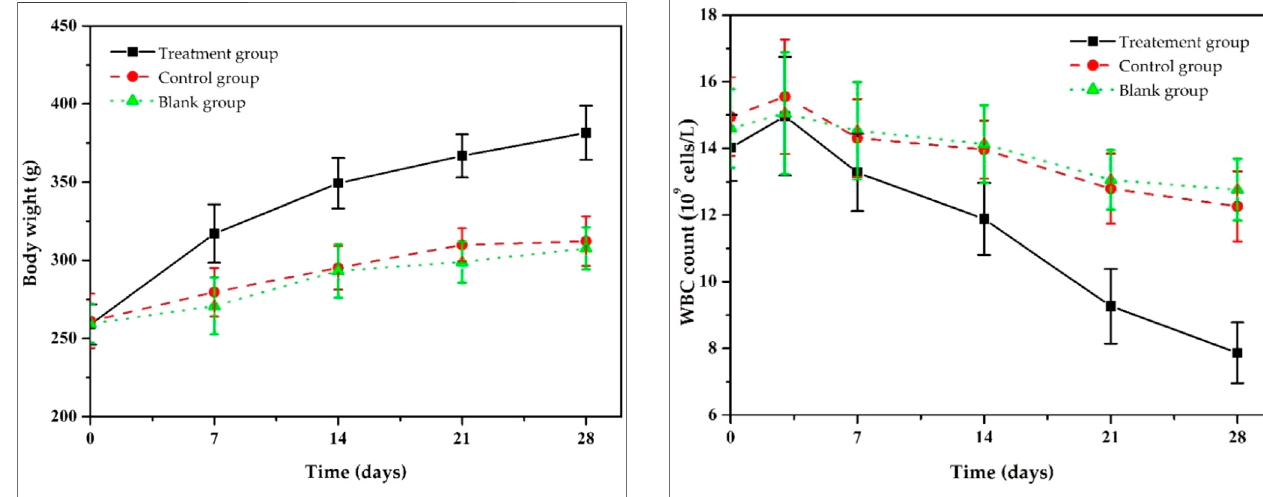
FIGURE9| Changesinwhitebloodcellcountssofchronicosteomyelitis model rats during